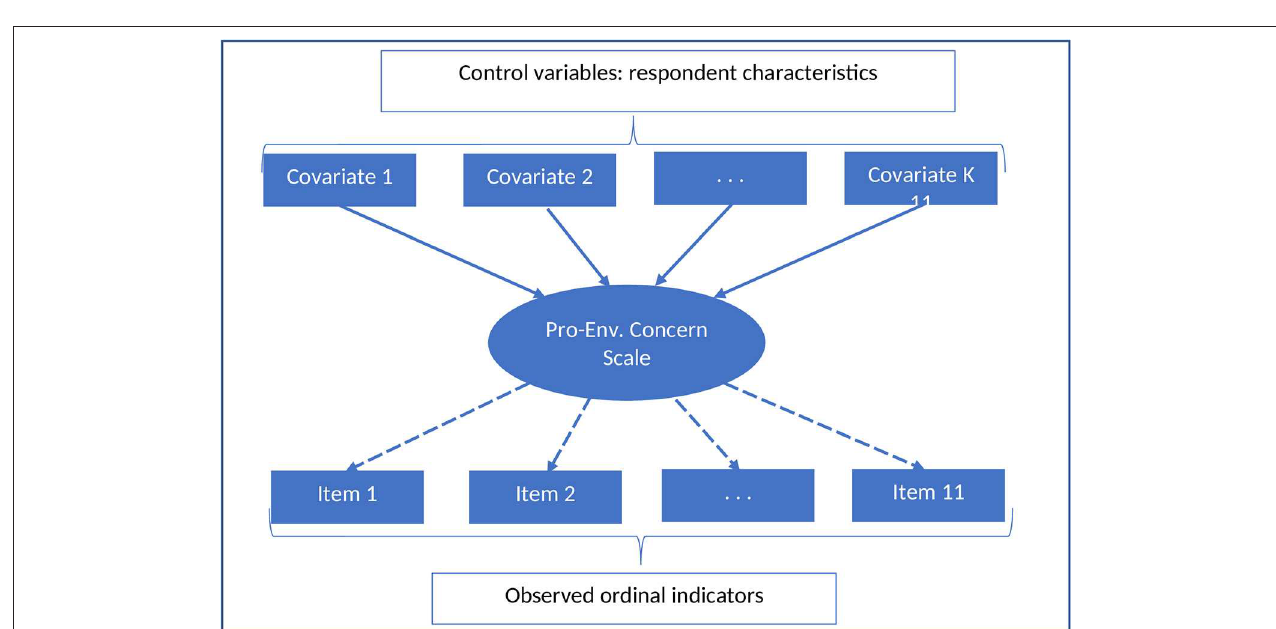
FIGURE 2 | A MIMIC Model of single latent variable: pro-environmental